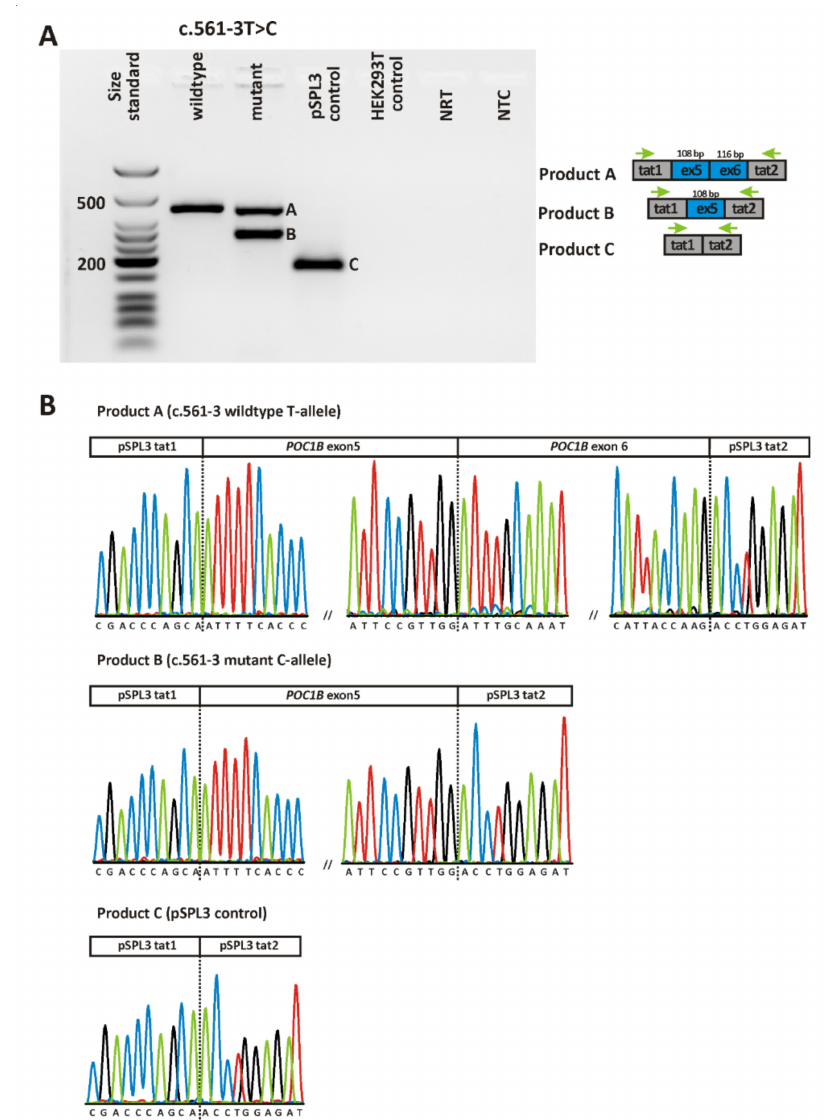
Figure 4. In vitro splicing assay for variant c.561-3T>C. ( A ) Agarose gel electrophoresis of RT-PCR products. Gel loading is as follows: A size standard (low molecular weight DNA ladder, NEB) is loaded in the leftmost lane. The RT-PCR product derived from HEK293T cells transfected with a plasmid construct harboring the wildtype allele is shown in lane 2, while the RT-PCR products obtained upon transfection with the mutant allele are shown in lane 3. RT-PCRs from transfection with empty pSPL3 vector (lane 4) and untransfected HEK293T cells (lane 5) served as controls. NRT (lane 6), no reverse transcriptase control; NTC (lane 7), no template control. Schemes of the amplified products are presented next to the agarose gel picture. Grey boxes represent pSPL3 resident exons tat1 and tat2, and blue boxes POC1B exons, respectively. The green arrows indicate the location of the RT-PCR primers. ( B ) Sequencing analysis of RT-PCR products. Sequencing analysis shows that the single RT-PCR product derived from transfection with the wildtype minigene construct corresponds to correct splicing (i.e., splicing of POC1B exons 5 and 6 between the pSPL3 resident exons tat1 and tat2), while the smaller transcript expressed by cells transfected with the mutant minigene construct shows skipping of exon 6. The bigger transcript corresponds to correct splicing (not depicted). Sequence analysis of the single RT-PCR product obtained from cells transfected with the “empty” pSPL3 plasmid shows that the two resident exons of the pSPL3 vector (i.e., tat1 and tat2) are spliced